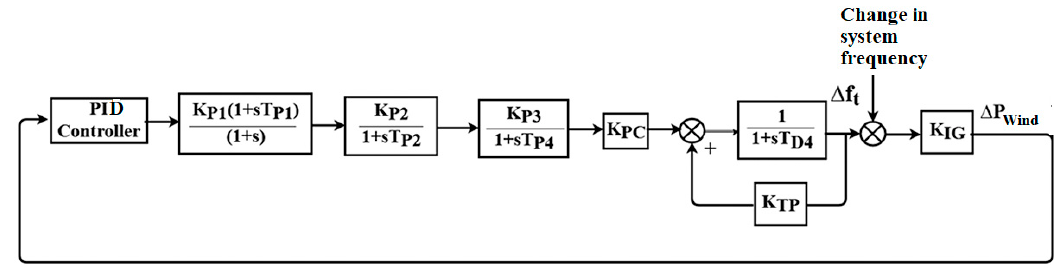
Figure 7. O ff shore wind generating Figure 7. Offshore wind generating system.